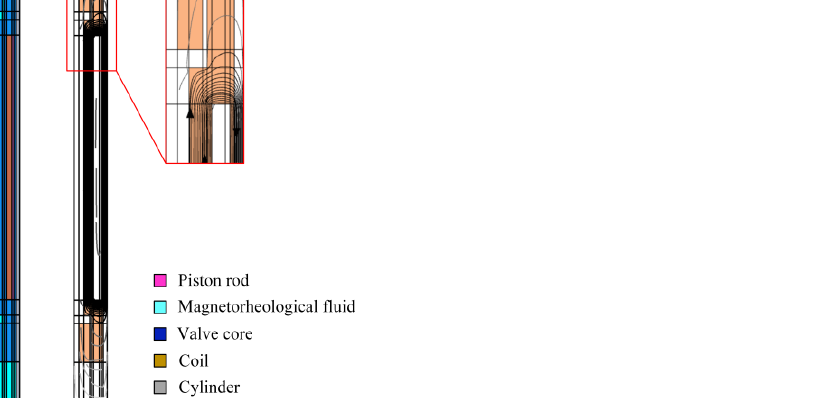
Figure 10. Geometric model and the magnetic field distribution of the designed VSB.